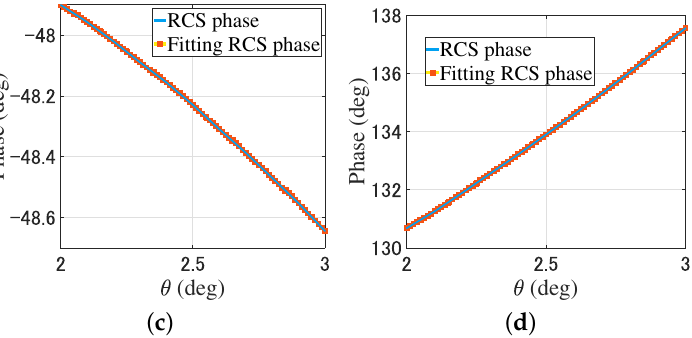
Figure 6. Comparison of the plate and trihedral corner reflector monostatic RCS. ( a ) The RCS amplitude of the plate. ( b ) The RCS amplitude of the trihedral corner reflector. ( c ) The RCS phase of the plate. ( d ) The RCS phase of the trihedral corner reflector.